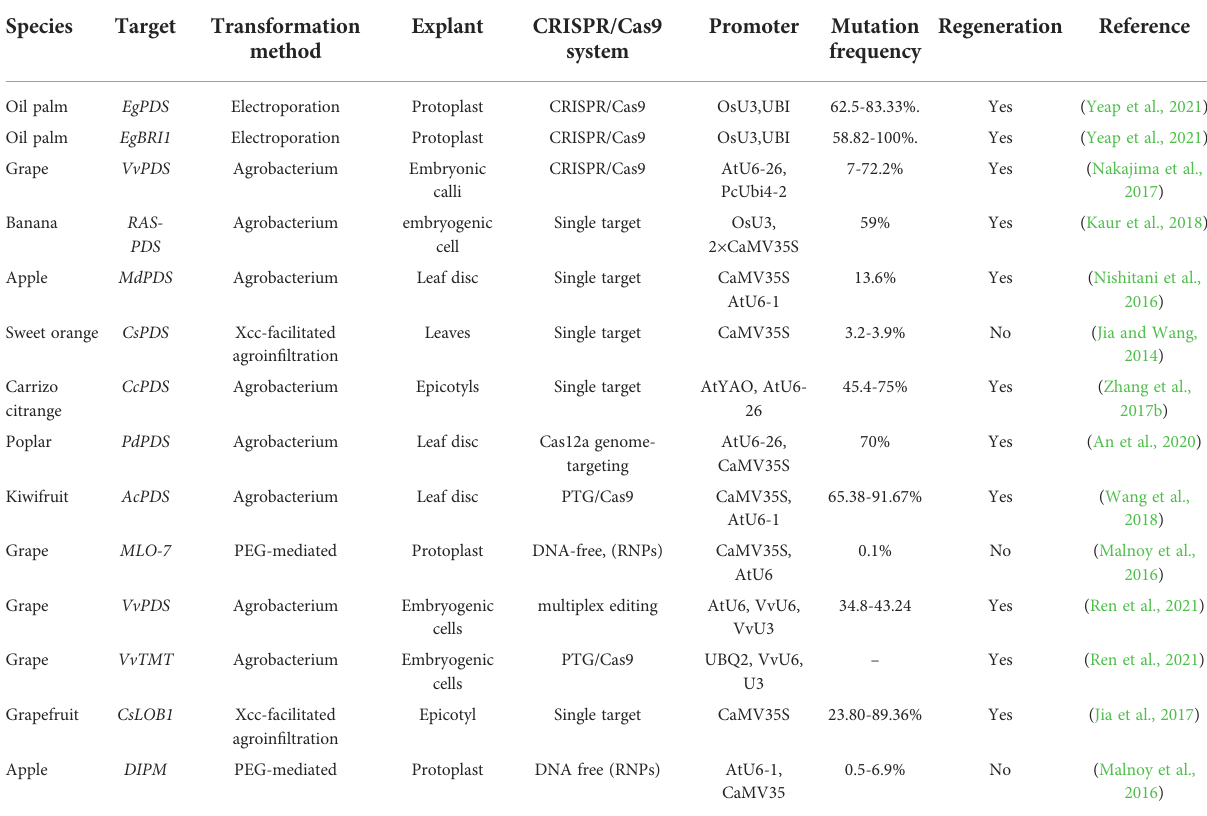
TABLE 1 CRISPR-based GE in